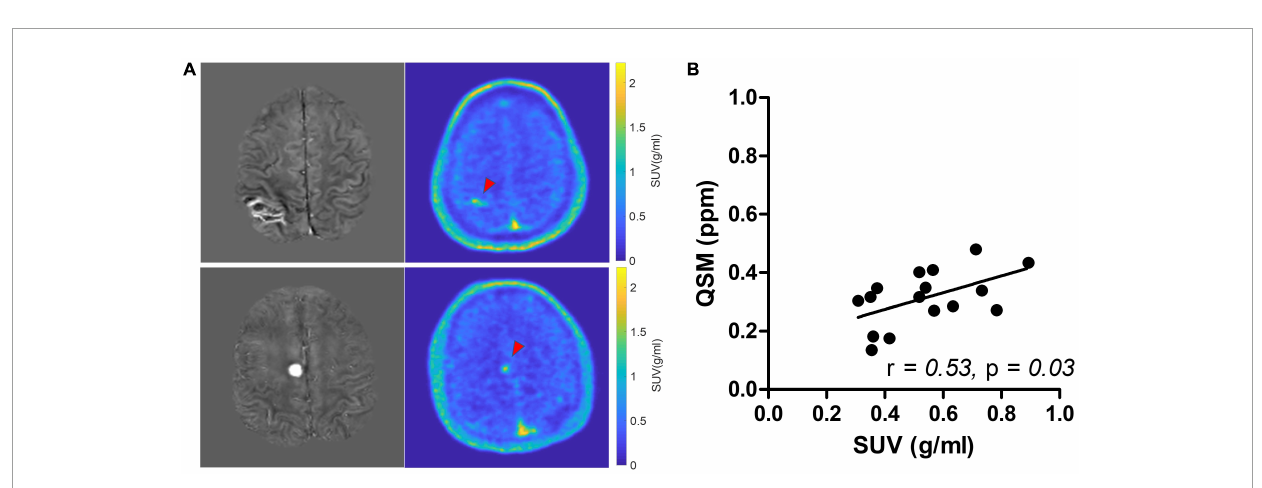
FIGURE4 (A) Comparison of QSM (left) and SUV map of flutriciclamide (right) of two representative cerebral cavernous malformations (CCM) cases. The red arrow points at the CCM lesion in the brain. (B) Correlation of flutriciclamide SUV and QSM in CCM lesion.